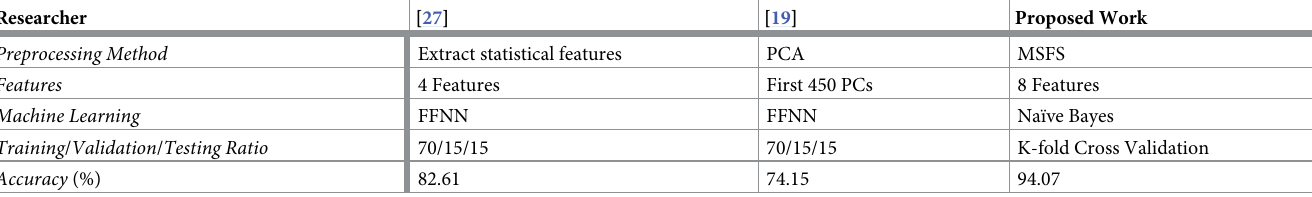
Table 9. Comparison with previous researches (Data from this research is fed into the the existing